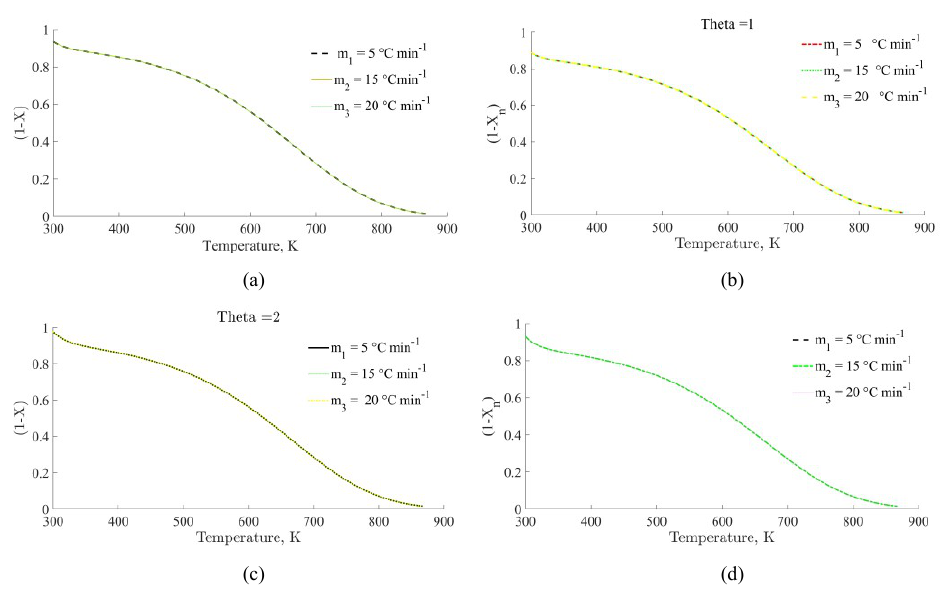
Fig. 5. The effect of heating rate ( m (°C min −1 )) on the numerical results of bi-variant scheme for DAEM: (a) first order reaction ( θ = 1); (b) n th order reaction ( θ = 1); (c) first order reaction ( θ = 2); (d) n th order reaction ( θ = 2) ( A = 1.5·10 −005 s −1 , η = 10 −9 kJ/mol, β = 0.0920, and n =